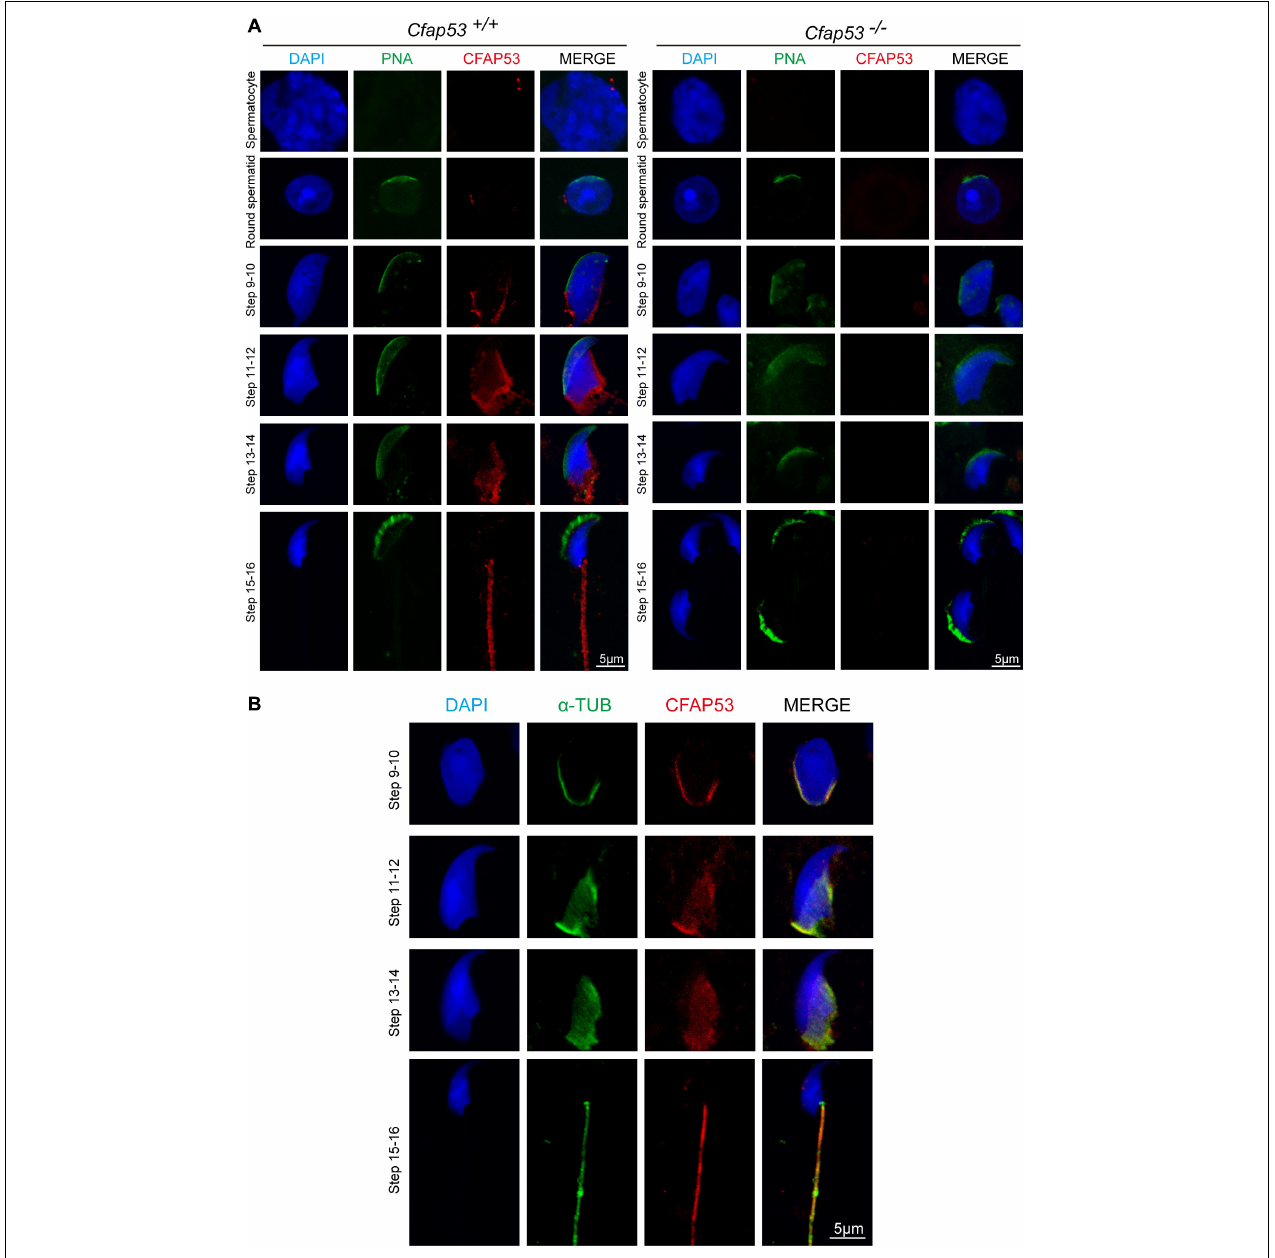
FIGURE 5 | Localization of CFAP53 in developing germ cells. (A) Testicular germ cells were prepared from Cfap53 + / + and Cfap53 − / − adult mouse testis, and immunofluorescence staining was performed with antibodies to CFAP53 (red). The acrosome was stained with PNA lectin histochemistry (green), and the nucleus was stained with DAPI (blue). (B) Testicular spermatids of WT adult mouse testes were stained with antibodies against α -tubulin (green) and CFAP53 (red). The nucleus was stained with DAPI (blue). In step 9–14 spermatids, CFAP53 was detected at the manchette. In 15–16 spermatids, CFAP53 was located at the sperm